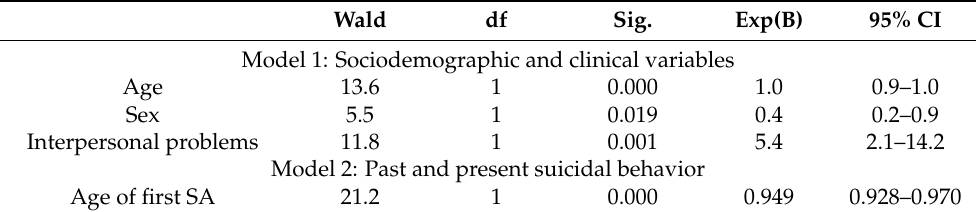
Table 3. Results of logistic regression analysis of MSSA with